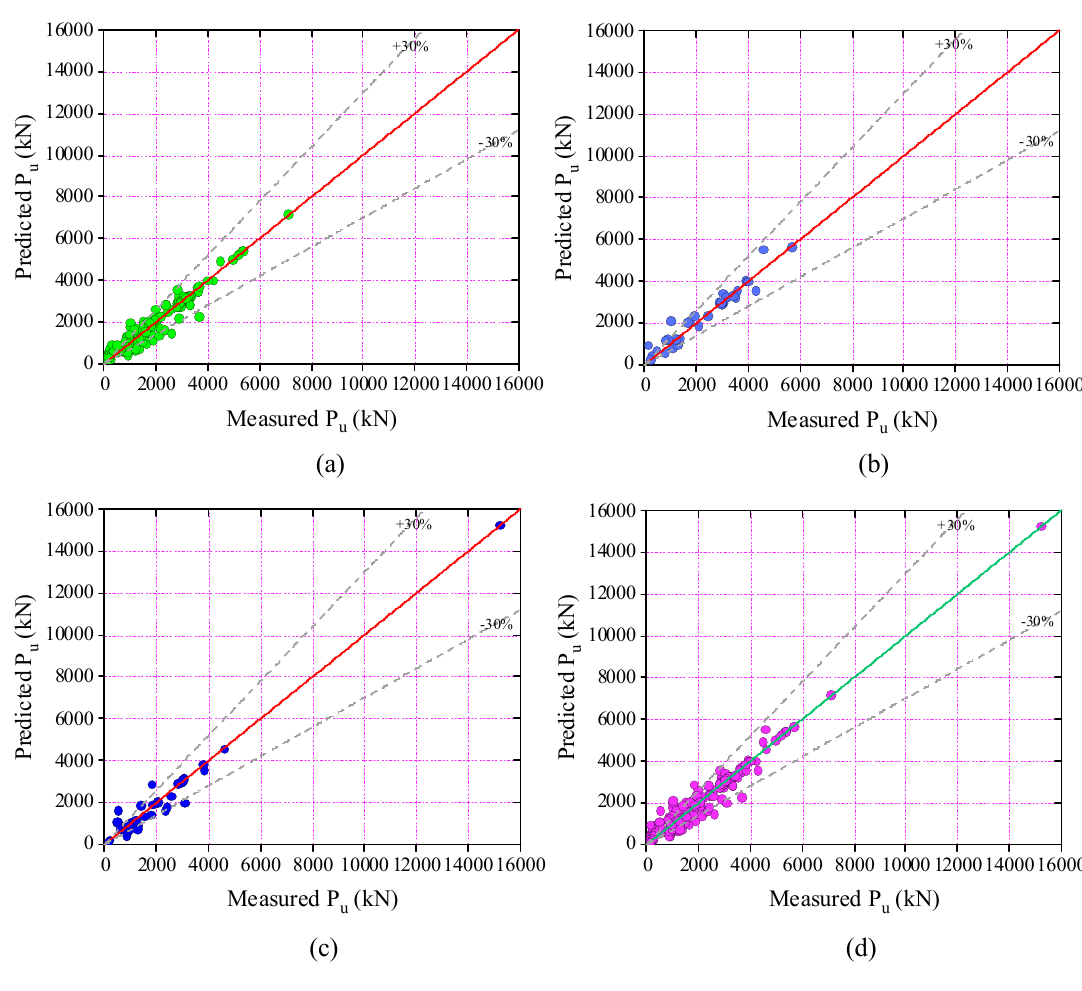
Figure 7. Results of ANN model ( a ) Training dataset, ( b ) Validation dataset, ( c ) Testing dataset, and ( d ) All datasets.